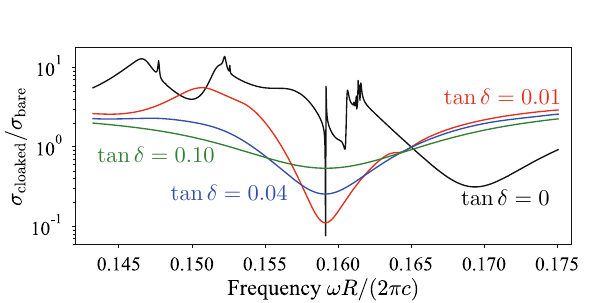
Figure 6. Scattering cross section of the designed cloaked materials with loss tangent tan δ